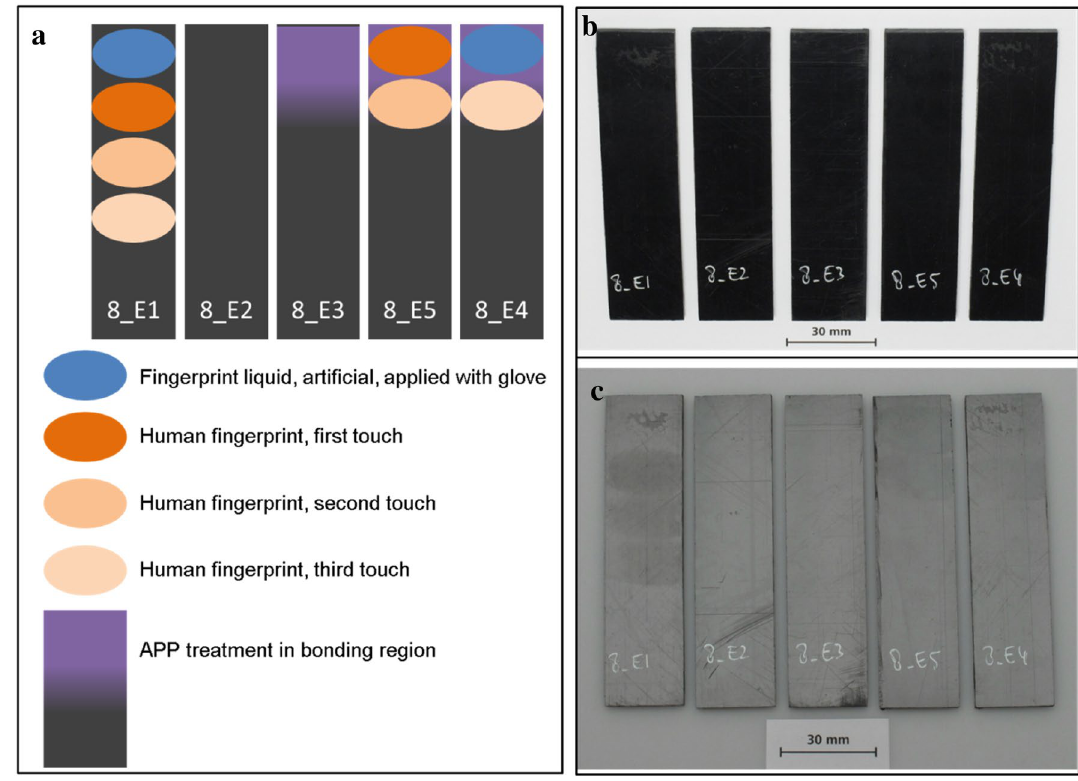
finger covered with a plastic glove. In other regions, after having once contacted the facial human skin around the nose greasy and saliferous fingerprints were applied by successively touching the adherend surface in three positions with a human